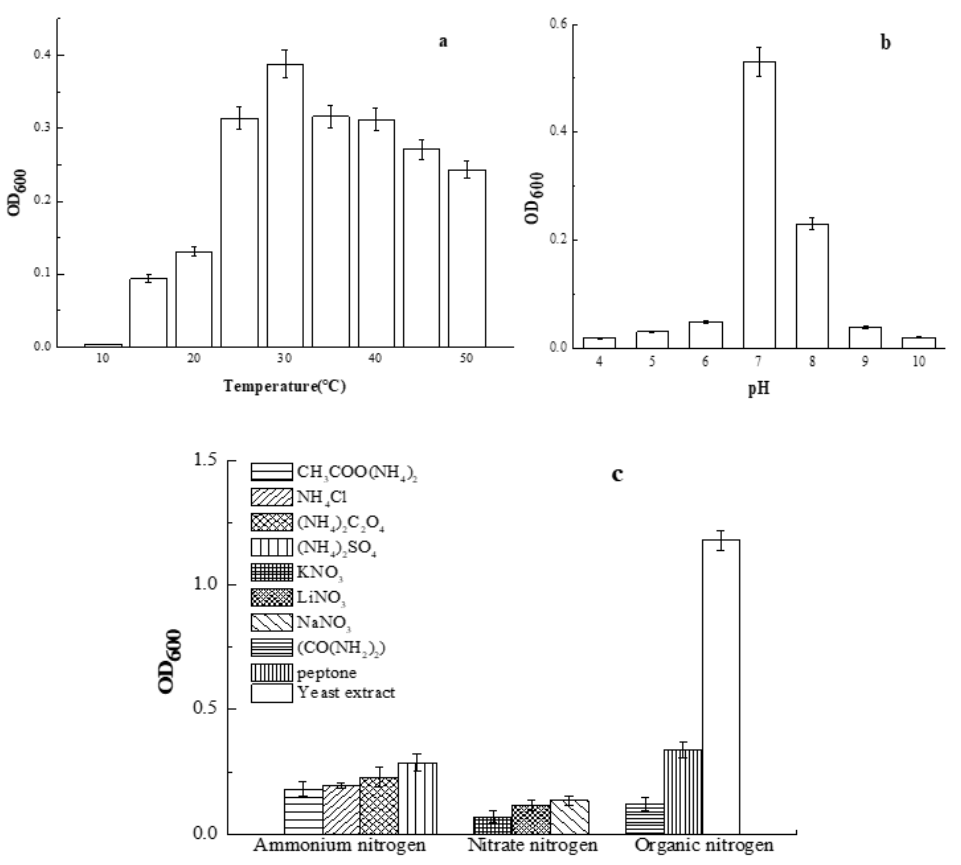
Figure 4. Effect of culture conditions on the growth of Smobiisys501. ( a ) represents the effect of temperature; ( b ) represents the effect of pH; ( c ) represents the effect of nitrogen sources.